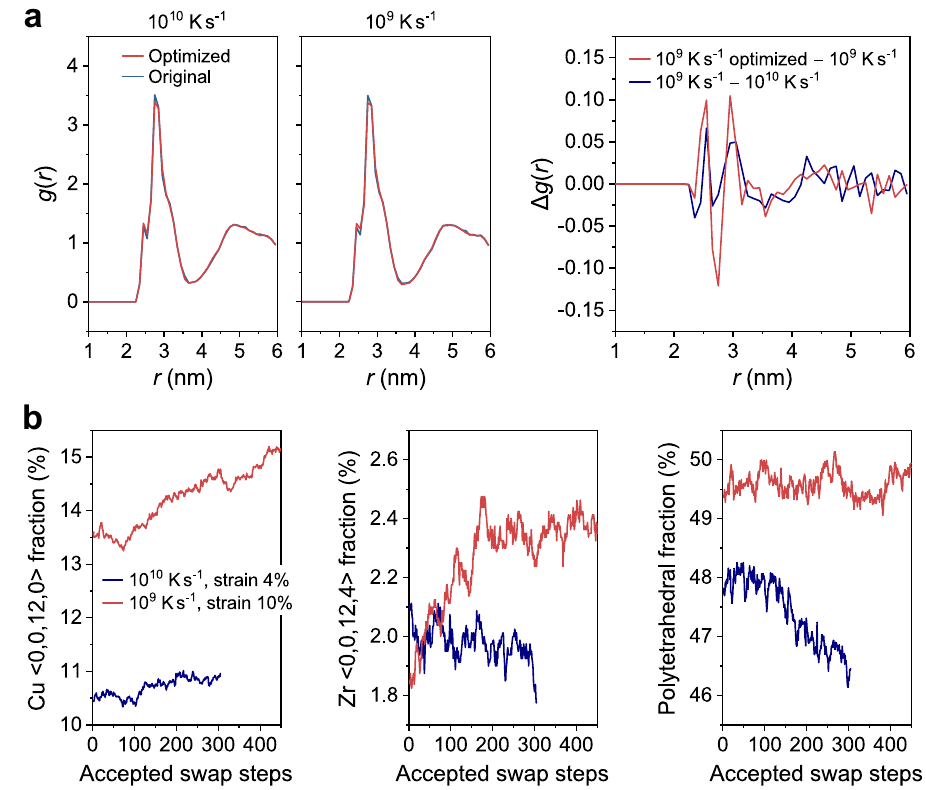
Fig. 5 Structural evolution with optimization. a Pair correlation function, g ( r ), of the original Cu 50 Zr 50 − 10 10 K s − 1 and 10 9 K s − 1 con fi gurations and of the GNN-optimized con fi gurations. Δ g ( r ), the difference of g ( r ) between two states, induced by the GNN-guided optimization and the decrease of quenching rate are derived and compared. b Tracking the fraction of typical Voronoi motifs, i.e., Cu-centered <0, 0, 12, 0> icosahedra, Zr-centered <0, 0, 12, 4> and polytetrahedral clusters, during the optimization